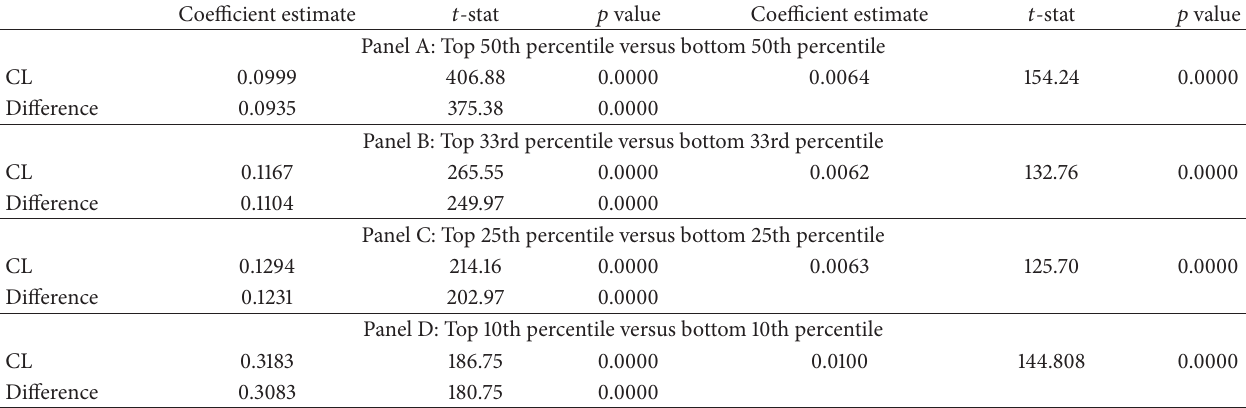
Table 6: Bootstrap results of significance of the difference in the CL coefficient between high and low cost leadership